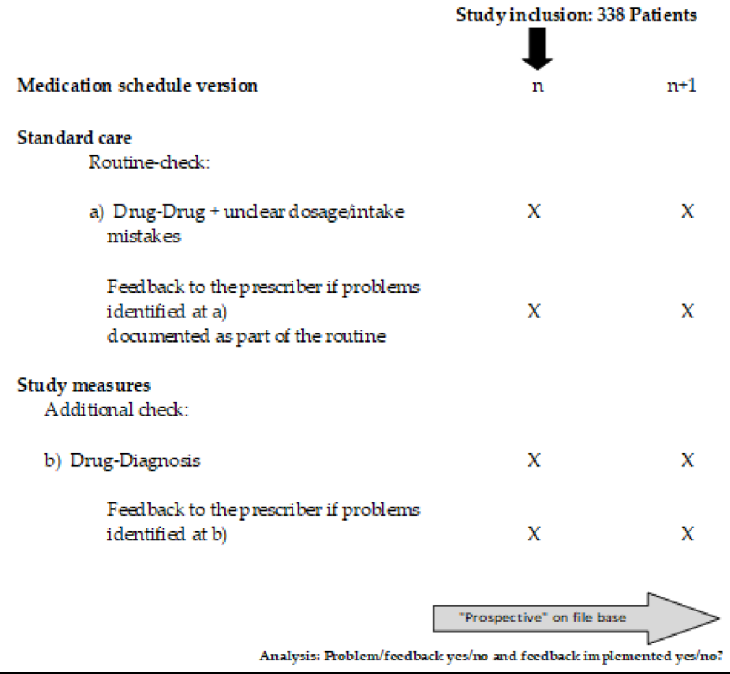
Figure 1. Overview of standard care and study